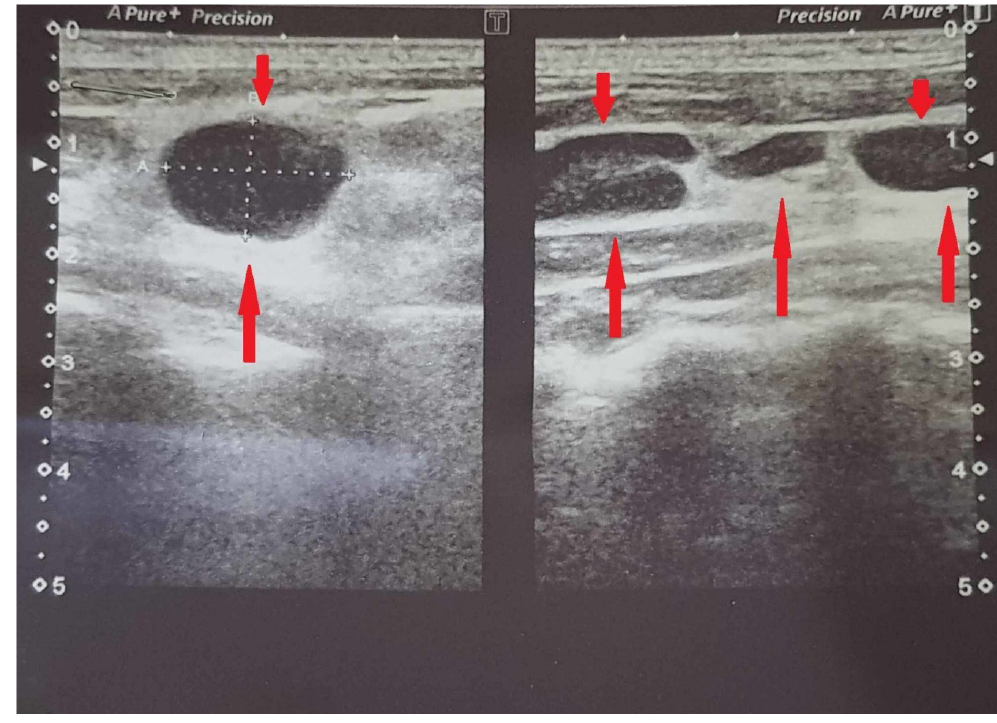
Figure 1. Ultrasound of neck showing enlarged supraclavicular and cervical and lymph nodes (Left